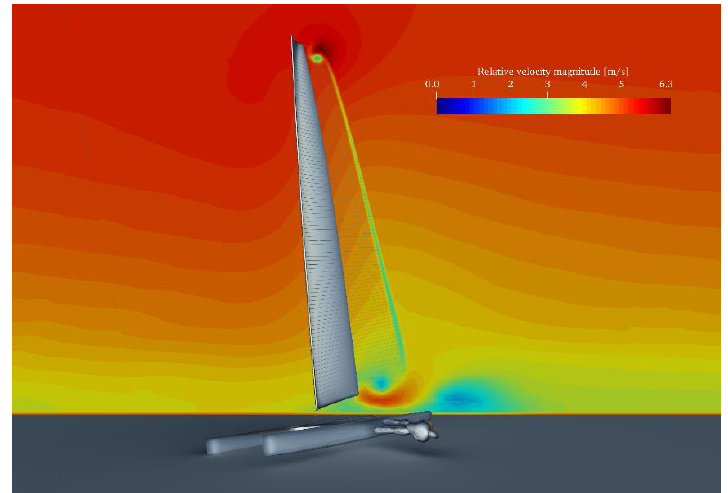
Figure 18. Typical CFD solution on an A-Class catamaran.